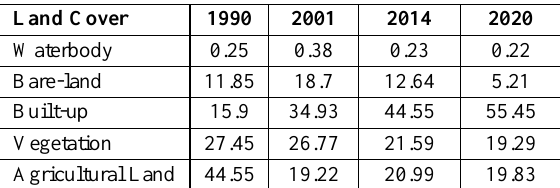
Table 2: Percentage of land cover change from 1990 to 2020